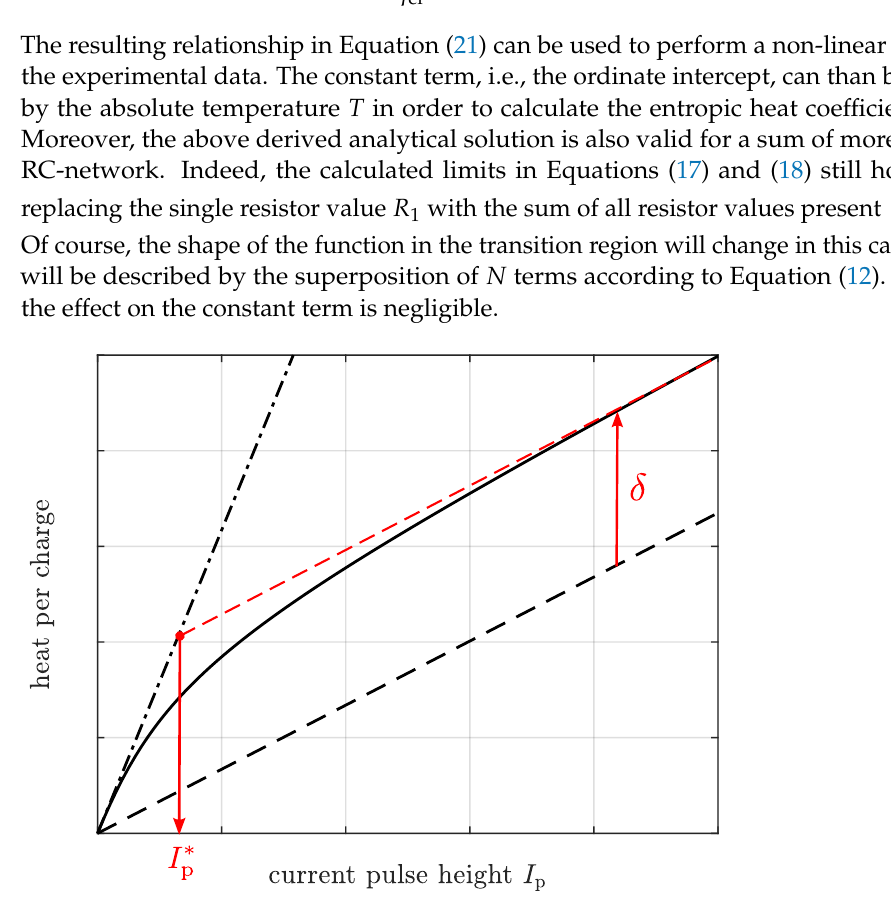
Figure 3. Qualitative characteristic of the irreversible heat generated as a function of the current pulse height. The heat is normalized with the constant amount of electrical charge q el transferred during each current pulse. Analytical solution ξ ( I p ) as given in Equation (13) (solid line), solution for a purely ohmic internal resistance R 0 · I p (dashed line) and solution for a fully charged RC-network ( R + R ) · I p (dot-dashed line) . The transition current I ∗ 0 1 p and the constant offset δ are marked in